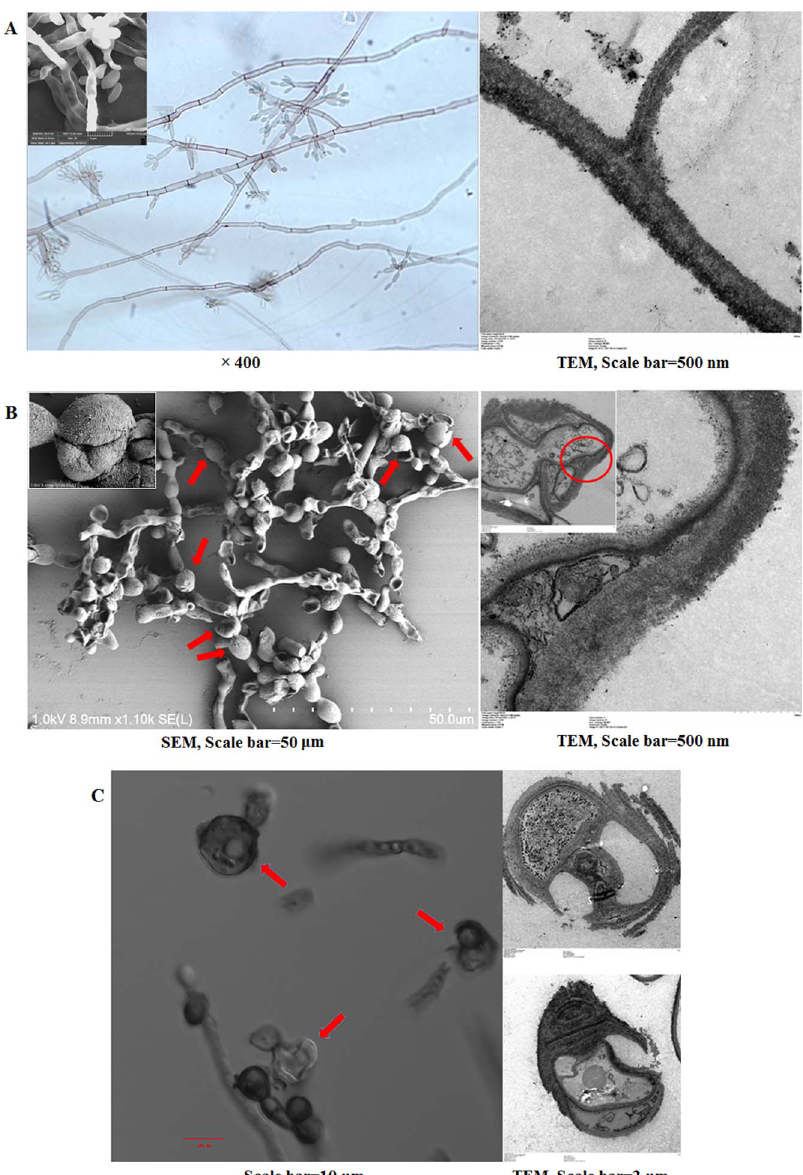
Fig. 3. In vitro-transformed sclerotic cells with multi-planate division were damaged by hydrogen peroxide. (A and B) SEM and TEM as well as optical microscope were used to characterize the morphology of saprophytic F. pedrosoi (A) and transformed sclerotic cells in ATCC medium 830 (B), as indicated by the red arrows. TEM, scale bar 5 500 nm; SEM, scale bar 5 50 m m. (C) Confocal microscope and TEM were used to observe the integrity of transformed sclerotic cells after treatment with 1% hydrogen peroxide. The destroyed sclerotic cells were indicated by red arrows. Confocal, scale bar 5 10 m m; TEM, scale bar 5 2 m m.